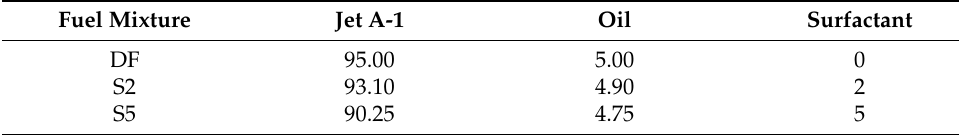
Table 2. Percentage mass fraction of components in fuel